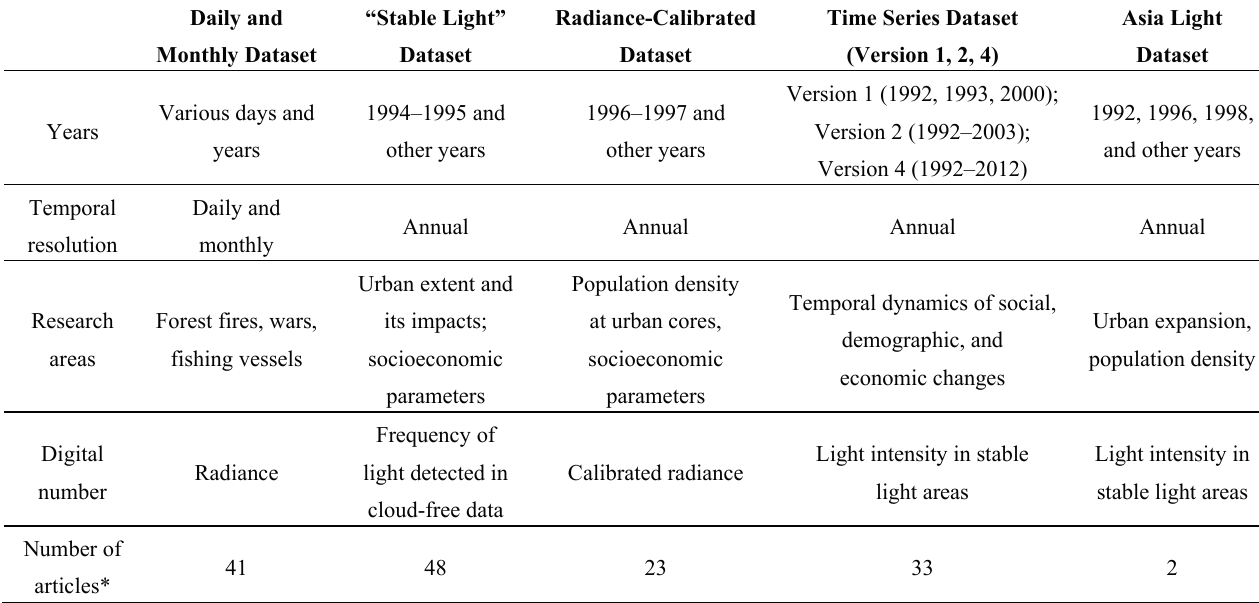
Table 1. Characteristics and usage of five commonly utilized datasets extracted from DMSP/OLS nighttime